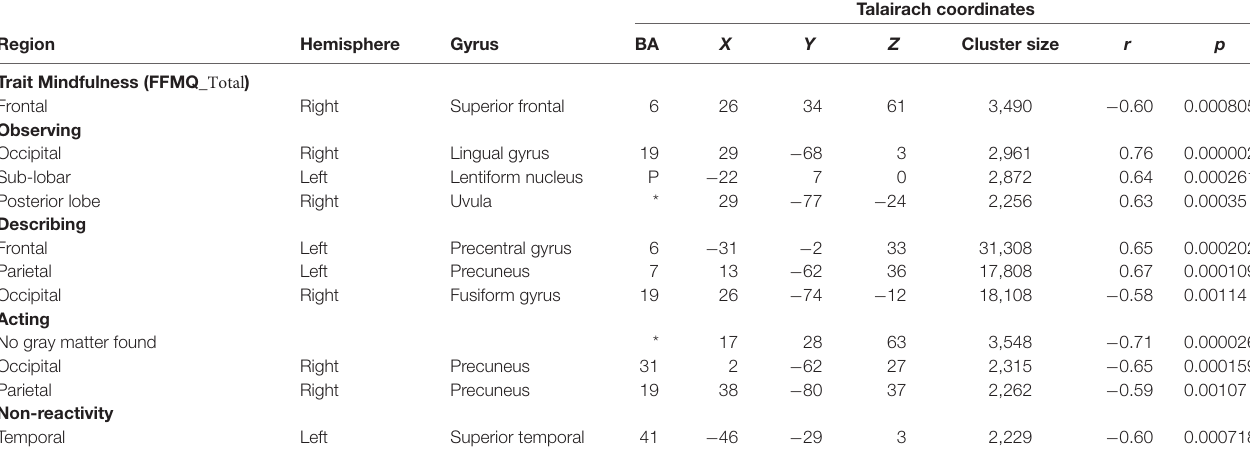
TABLE 4 | Talairach coordinates of correlations between FFMQ scores and functional connectivity with the central executive network (CEN).